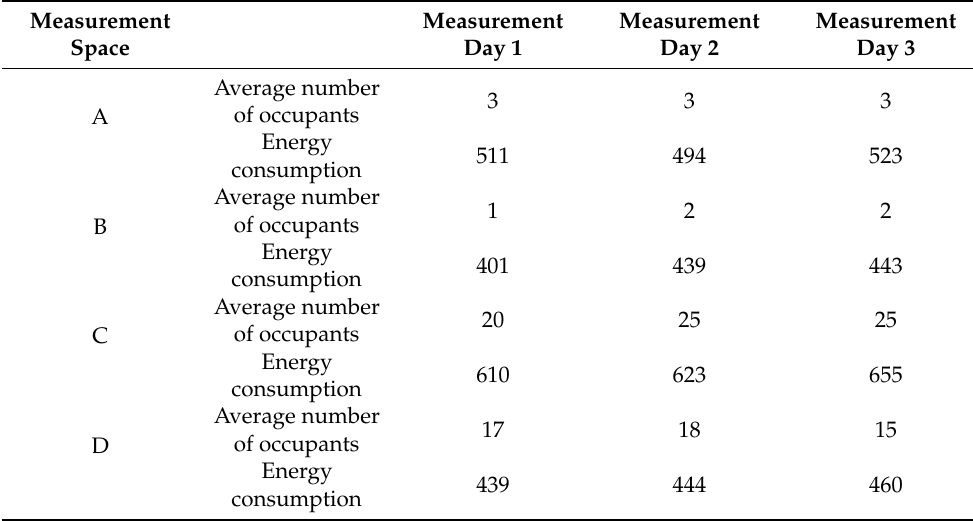
Table 6. Calculation of the energy consumption of each room (Wh/m 2 · Day).